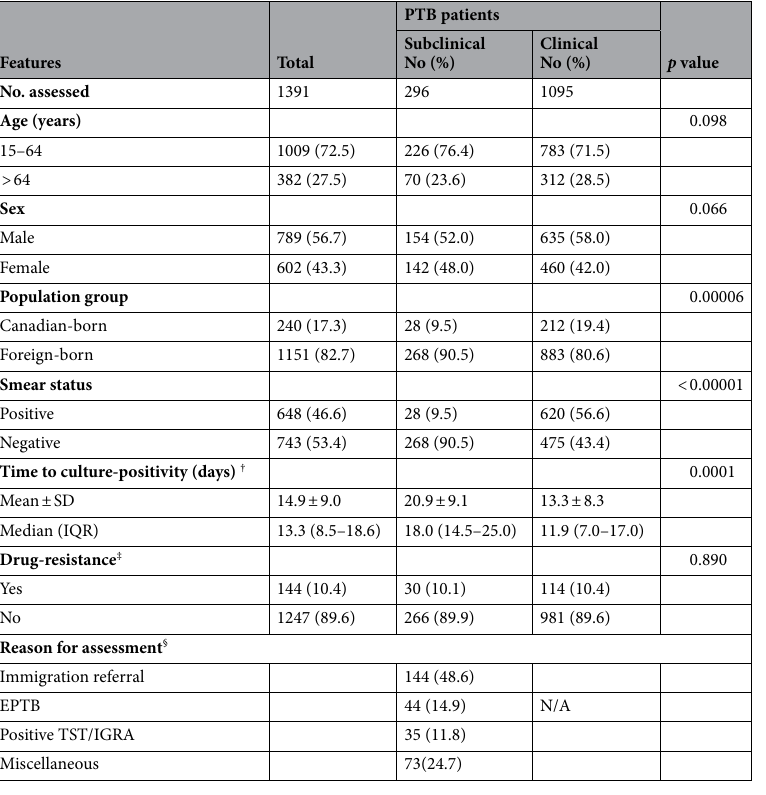
Table 1. Demographic and mycobacteriologic features in HIV-seronegative, new-active pulmonary tuberculosis patients by symptom status; reason for assessment of subclinical patients Abbreviations: HIV human immunodeficiency virus; PTB pulmonary tuberculosis; SD standard deviation; IQR interquartile range; EPTB extrapulmonary tuberculosis; TST tuberculin skin test; IGRA interferon gamma release assay; NA not applicable. The patients reported in Table 1 are a subset of patients previously reported (see reference #6). † If multiple pre-treatment specimens were culture-positive, the average time to culture-positivity was used. ‡ Resistance to one or more first-line anti-tuberculosis drugs. § See text for a full description of the reason for assessment.